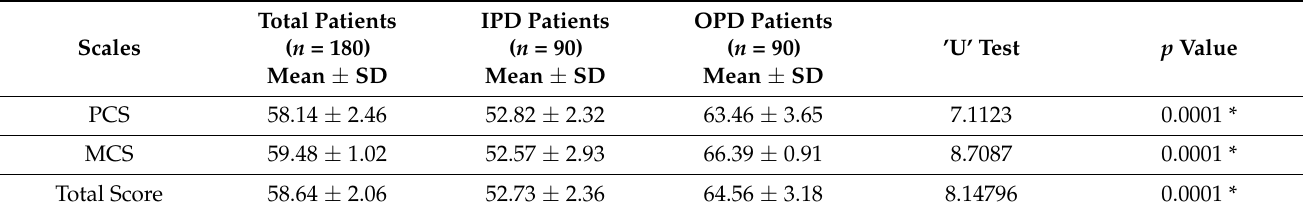
Table 4. KDQOL-SF summary scores of the patients ( n = 180).